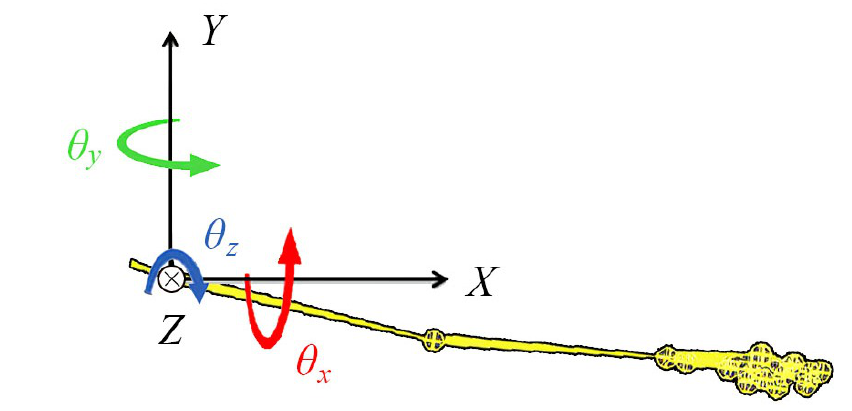
Figure 3. The skeleton hierarchy of CMU motion capture data.